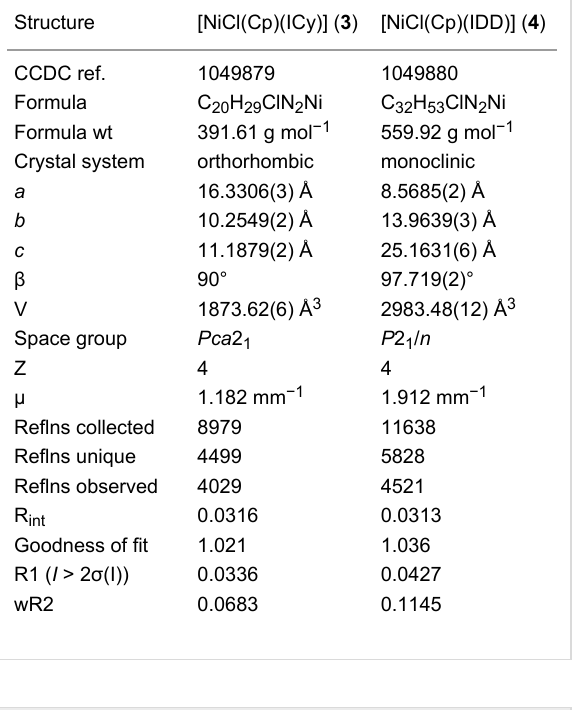
Table 1: Experimental data for single-crystal X-ray diffraction analyses of [NiCl(Cp)(ICy)] and [NiCl(Cp)(IDD)]. Structure